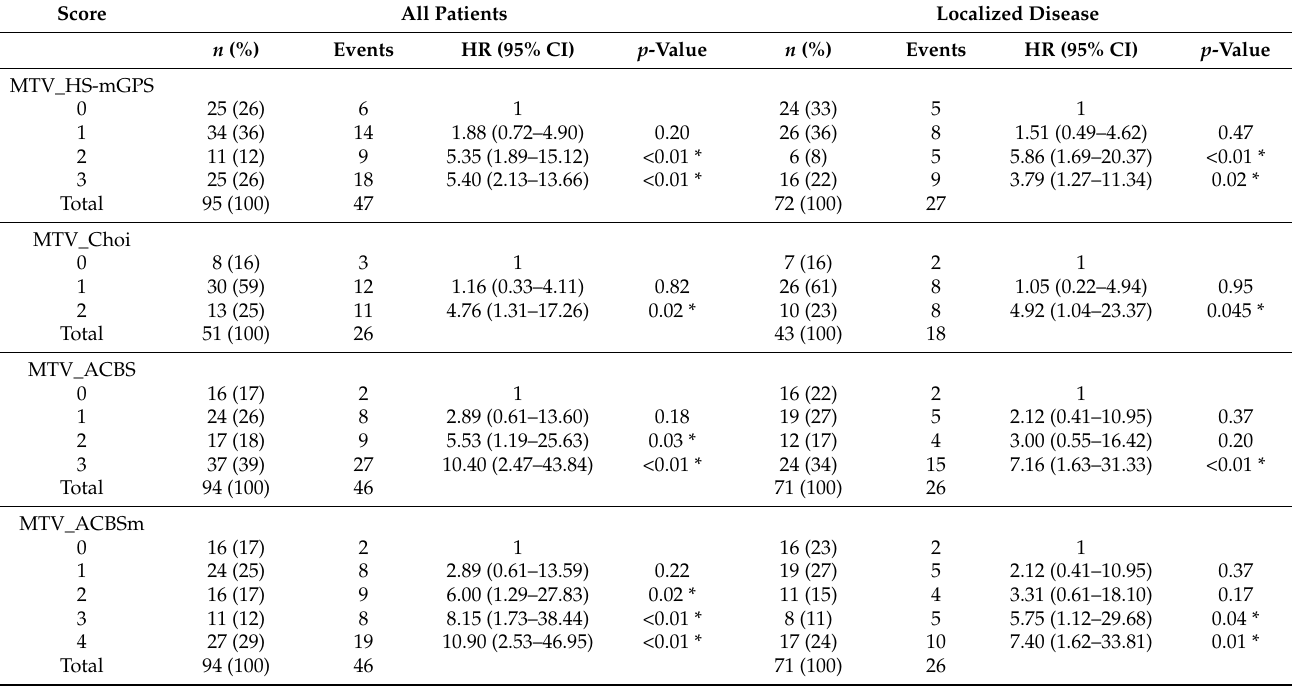
Table 3. Hazard ratios for overall survival in combined predictive